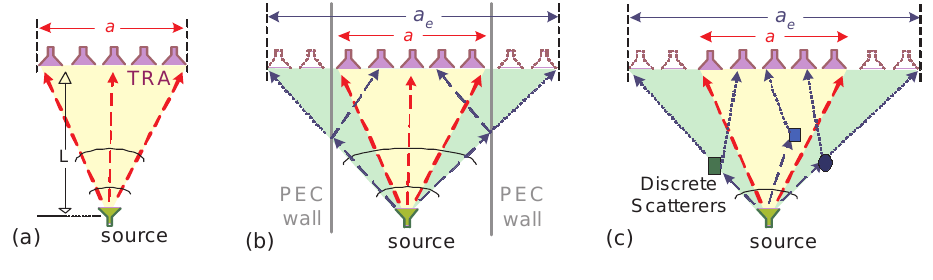
Figure 2. Effective aperture increase in media with multipaths. (a) Homogeneous medium with no multipaths ( a = a ), (b) multipaths created by the waveguide-like structure com- e posed of two perfect electric conductor (PEC) walls ( a discrete scatterers ( a > a e